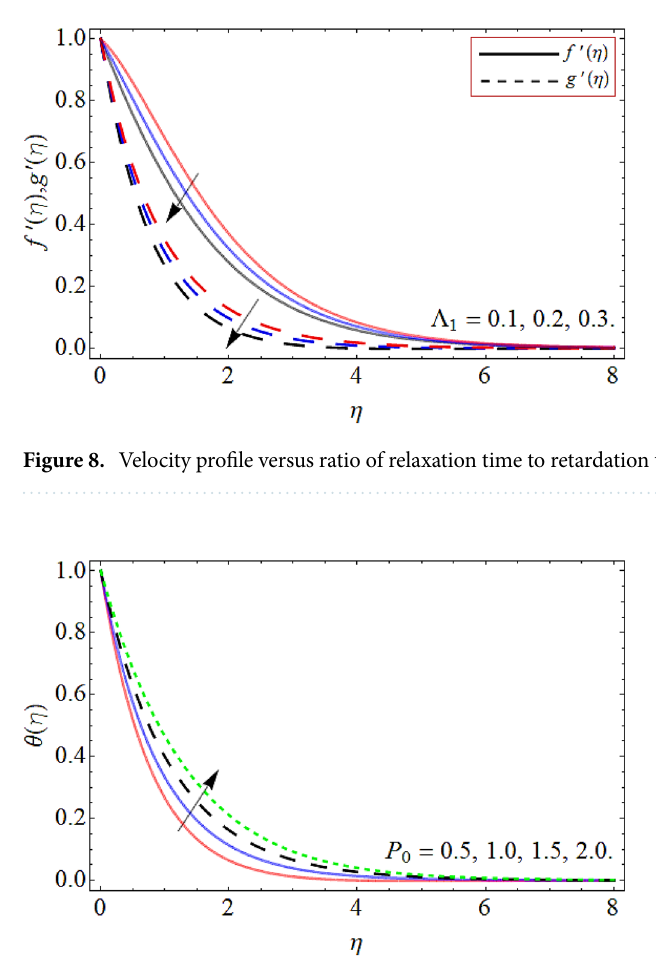
Figure 9. Energy profile versus the porosity term P 0 .